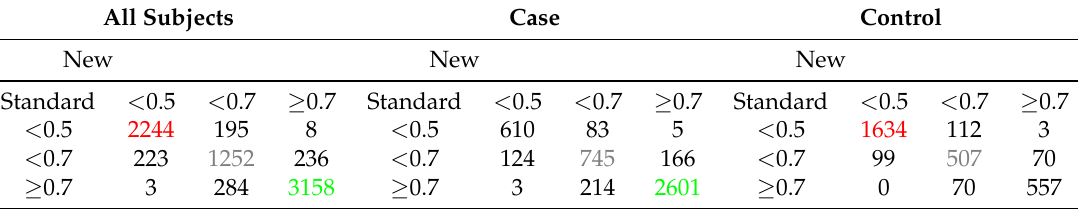
Table 5. Reclassification table obtained for model 3 using NRI; 0.5 and 0.7 values represent the cutoff range used to calculate the risk category. Values in red represent true negatives, values in green represent true positives, and values in the cutoff range are presented in gray. False positives and false negatives are presented in black.